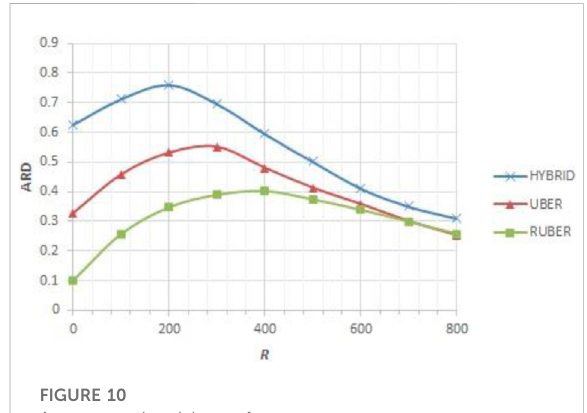
FIGURE 10 Average routing delay performance.